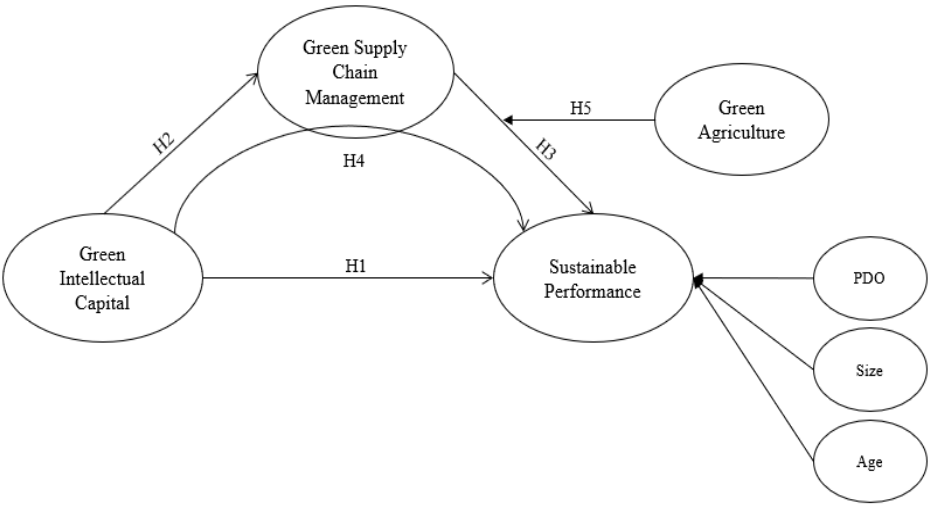
Figure 1. Proposed theoretical model. Source: Authors’ own